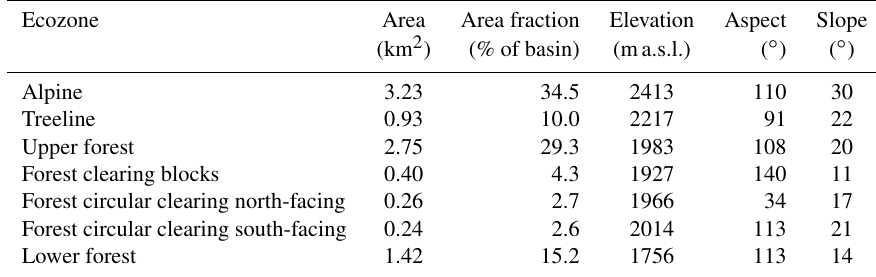
Table 1. Area and mean elevation, aspect, and slope for ecozones at the Marmot Creek Research Basin. Note that the aspect is in degrees clockwise from north.